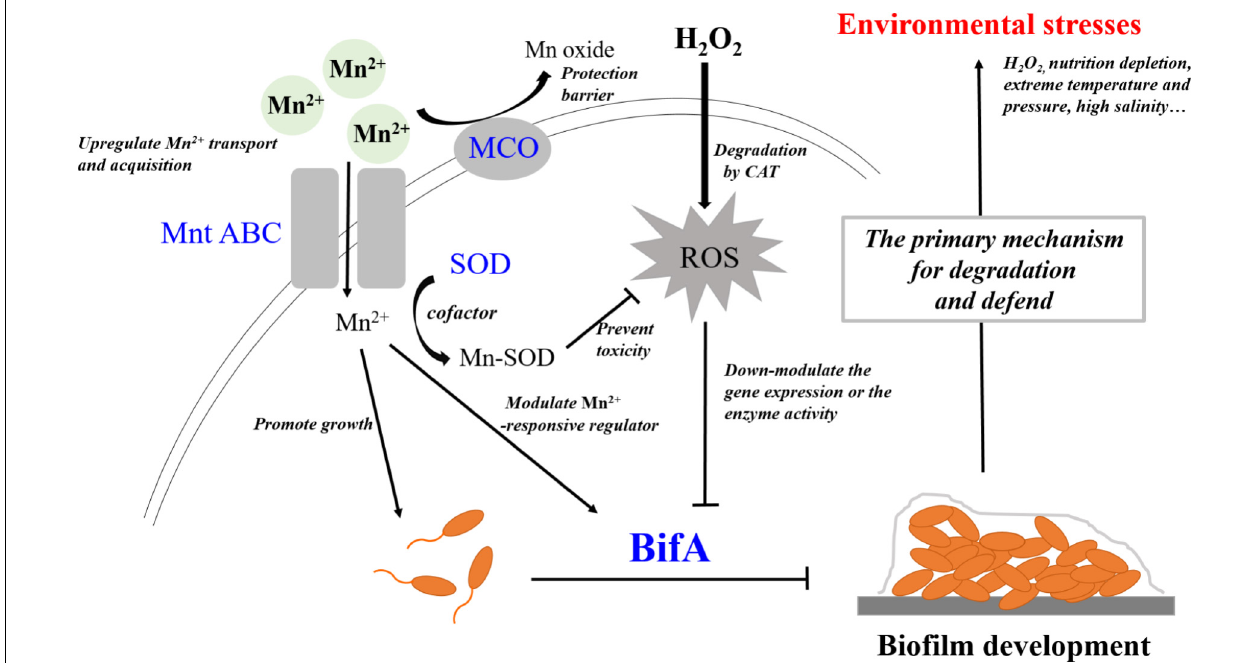
FIGURE 10 | BifA regulated-biofilm formation is a primary mechanism to defend exogenous H 2 O 2 exposure and closely correlates to cellular oxidative stress. Mn 2 + ion and H 2 O 2 represent 2 types of environmental factors, a trace nutrient substrate and an oxidative stress, respectively. Four genes that encode MCO, Mn 2 + transporter, SOD and BifA were assayed for their expression during bacterial growth following exposure to the two environmental factors Mn 2 + ion and H 2 O 2 on the growth, Mn 2 + acquisition, anti-oxidative system and biofilm formation in P. putida MnB1. Exogenous Mn 2 + promoted Mn 2 + uptake and acquisition. An increase in intracellular Mn 2 + may act as nutrient substrate promoting microbial growth. Alternatively, Mn 2 + may function as a cofactor for important enzymes, such as SOD, which scavenges ROS. Mn oxide, catalyzed by MCO is a barrier to protect from invasion, heavy metal and oxidative damage. Mn 2 + may target Mn 2 + -responsive regulators to inhibit biofilm formation by BifA up-regulation. Decrements in intracellular anti-oxidative system and the inhibition of biofilm formation suggests that Mn 2 + favors the microbial growth but suppresses biofilm development. Exogenous H 2 O 2 triggers intracellular ROS over-production, but does not significantly affect the proliferation of P. putida MnB1. Bio-degradation of exogenous H 2 O 2 and quick recovery of proliferative capacity at high H 2 O 2 levels are due to CAT activity. In contrast to the activation of anti-oxidative system, promotion of the biofilms by down-regulation of BifA gene or the blockade of BifA activity suggests that biofilm formation may be a primary mechanism by which P. putida MnB1 defends unfavorable environmental factors. Therefore, BifA-mediated biofilm formation may be more sensitive than anti-oxidative system in response to Mn 2 + ion and H 2 O 2 in P. putida MnB1. The sensitivity of BifA-mediated biofilm formation may highlight its role in the adaption of microbes to environment stress. MCO, Manganese oxidase; MntABC, ABC-Type manganese transporter; SOD, Superoxide dismutase;